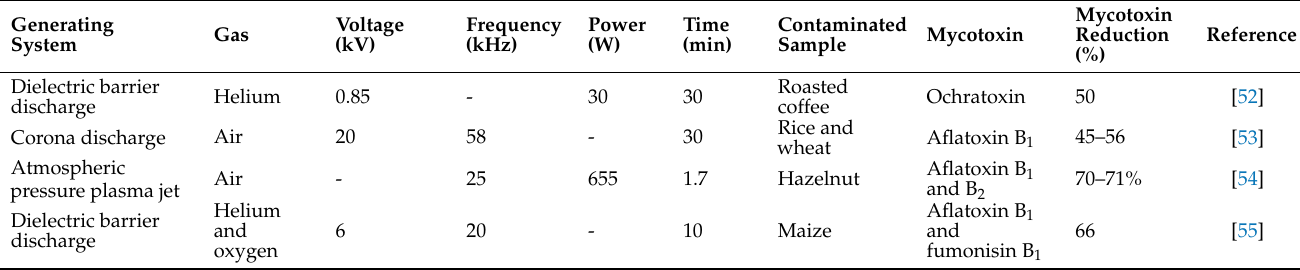
Table 1. Conditions applied for mycotoxin decontamination from some food samples using non-thermal plasma. Generating